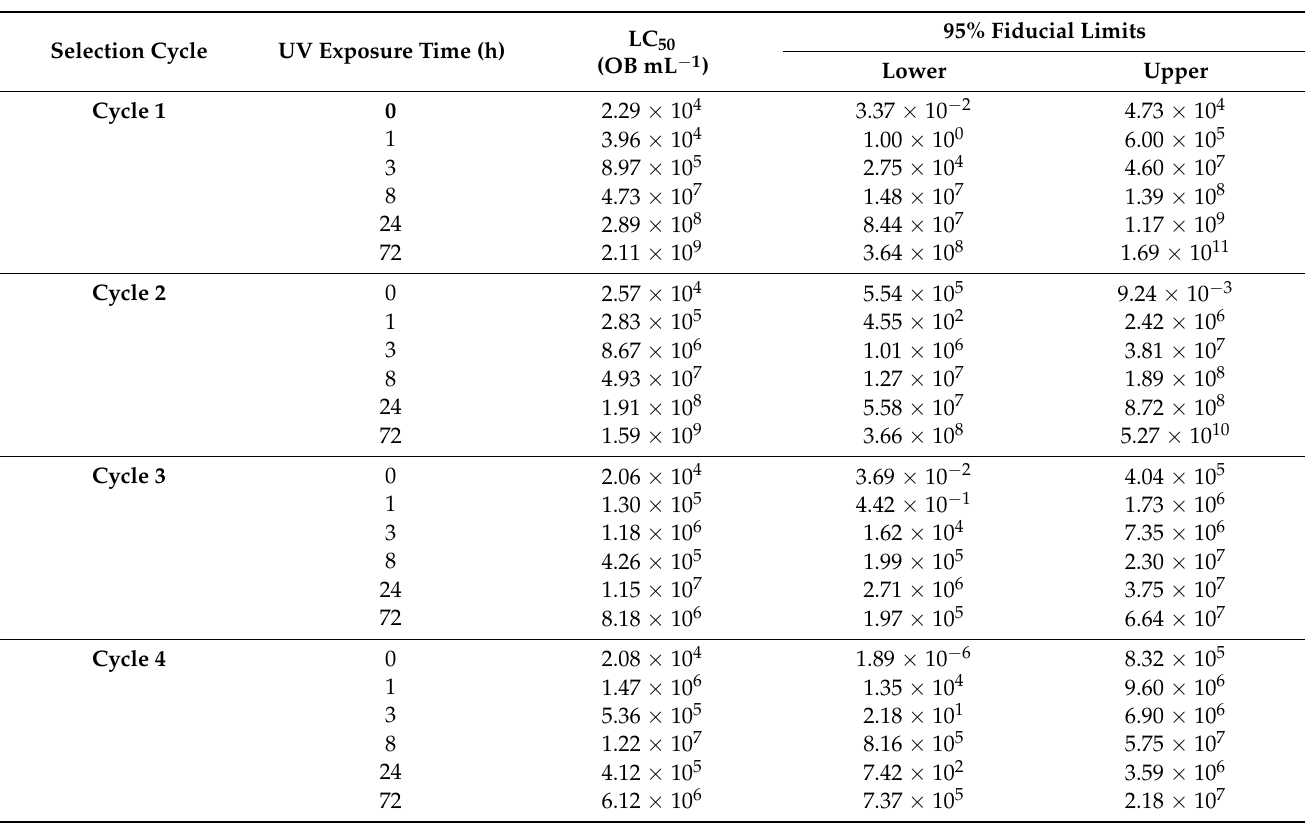
Table 1. LC 50 values derived from bioassay data of virus samples exposed to UV in five exposure